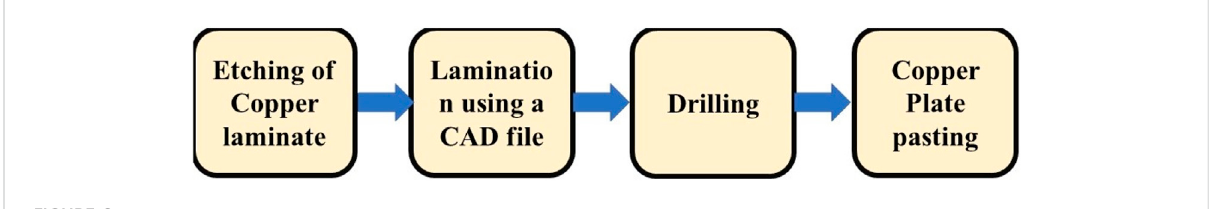
FIGURE 6 Flow chart of fabrication process.